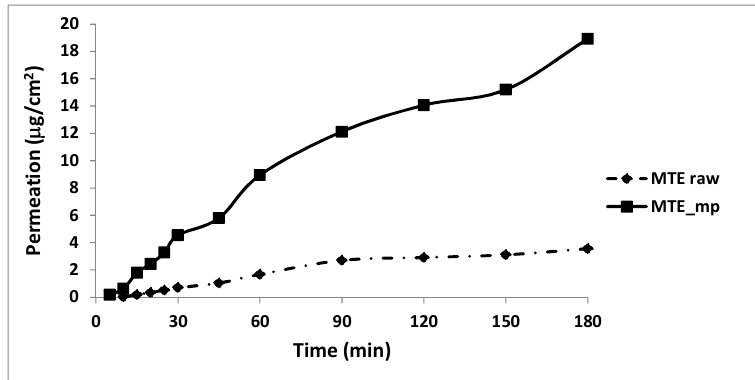
Figure 7. In vitro permeation profile. MTE raw extract (dotted line) and MTE_mp (black line) (standard deviation data <1%).